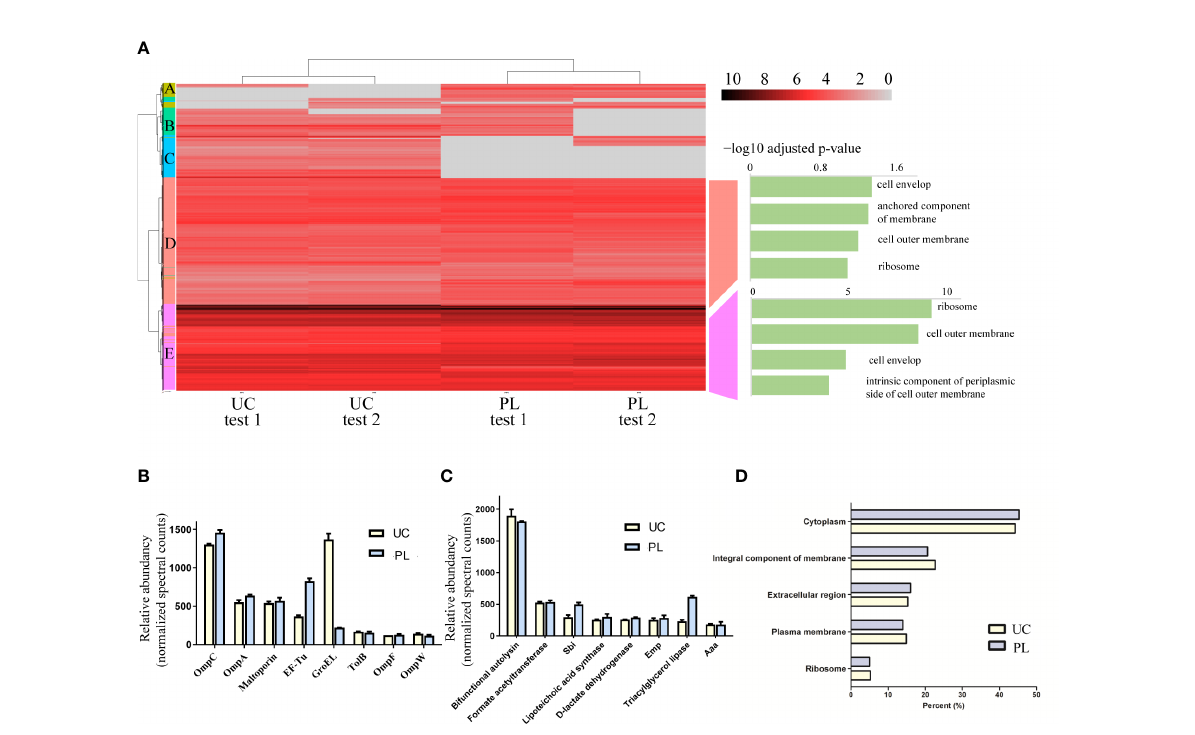
FIGURE 4 Identi fi cation of proteins isolated by the two methods. (A) Clustering analysis and subsequent GO enrichment for Cellular Components on the identi fi ed common clusters was performed for isolated samples from E. coli . The scale of the heatmap shows log2 transformed intensities of the proteins. Absent proteins are displayed in grey. (B) The abundance of representative proteins BEVs derived from E. coli isolated by UC and PL. (C) The abundance of representative proteins BEVs derived from S. aureus isolated by UC and PL. (D) Distribution of vesicular proteins derived from S. aureus based on their subcellular